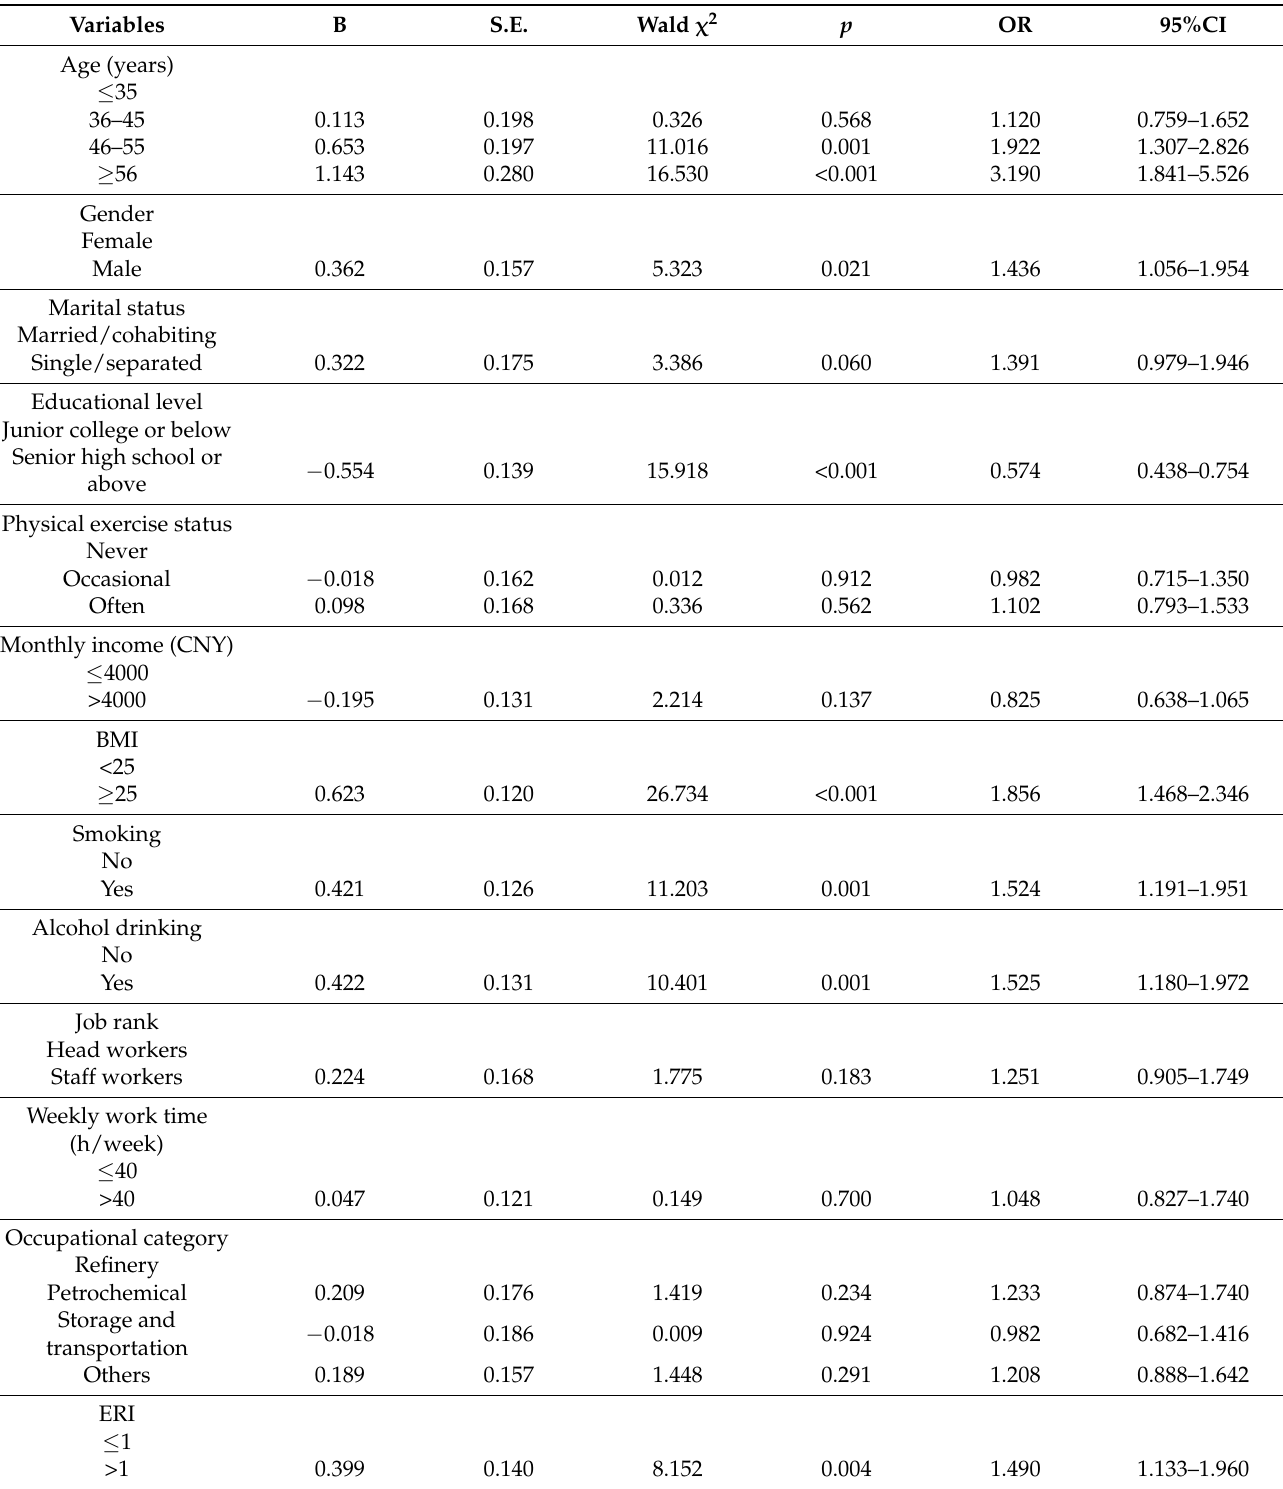
Table 2. Multivariable logistic regression on influencing factors for prevalence of